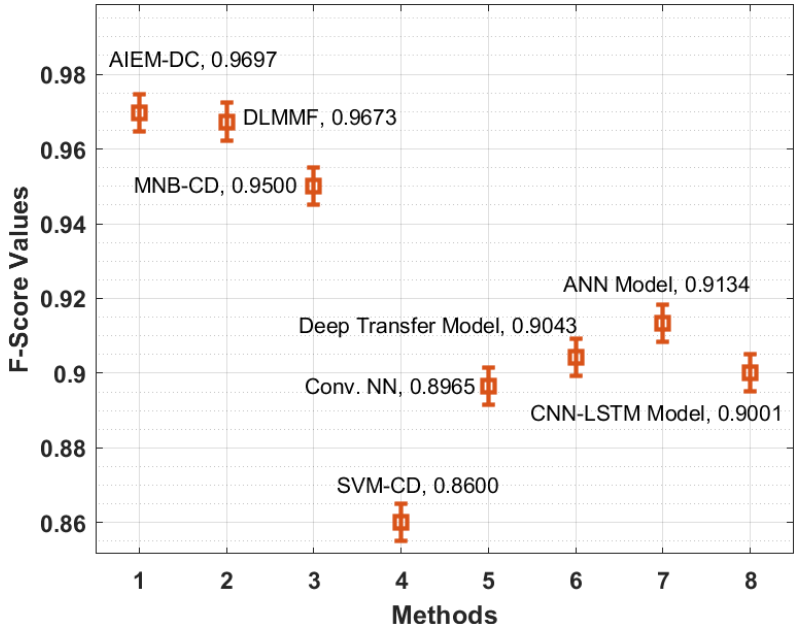
Figure 9. F-score analysis of the AIEM-DC model with existing approaches.